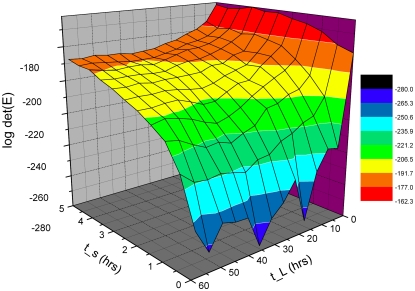
MINE calculation to determine when to start sampling (tL) and how often (tS).The MINE surface is plotted as function of the lag tL in hrs and spacing tS in hrs; higher values on the MINE surface suggest the preferred design points (tL, tS). Color contours of the log of the MINE criterion det(E) are overlayed as a function of the lag (tL) and spacing (tS) to show points on the surface of similar MINE values. The MINE surface suggests to start sampling immediately (small tL) and to make the spacing (tS) between observations as large as possible. The maximum permissible spacing (ts) between observations is 5 hrs, as determined by two constraints. One, there is the cost constraint of 13 microaray chips per cycle, and two, beyond a 50 hr experiment in cycle 1 stable oscillations in liquid culture are not guaranteed.